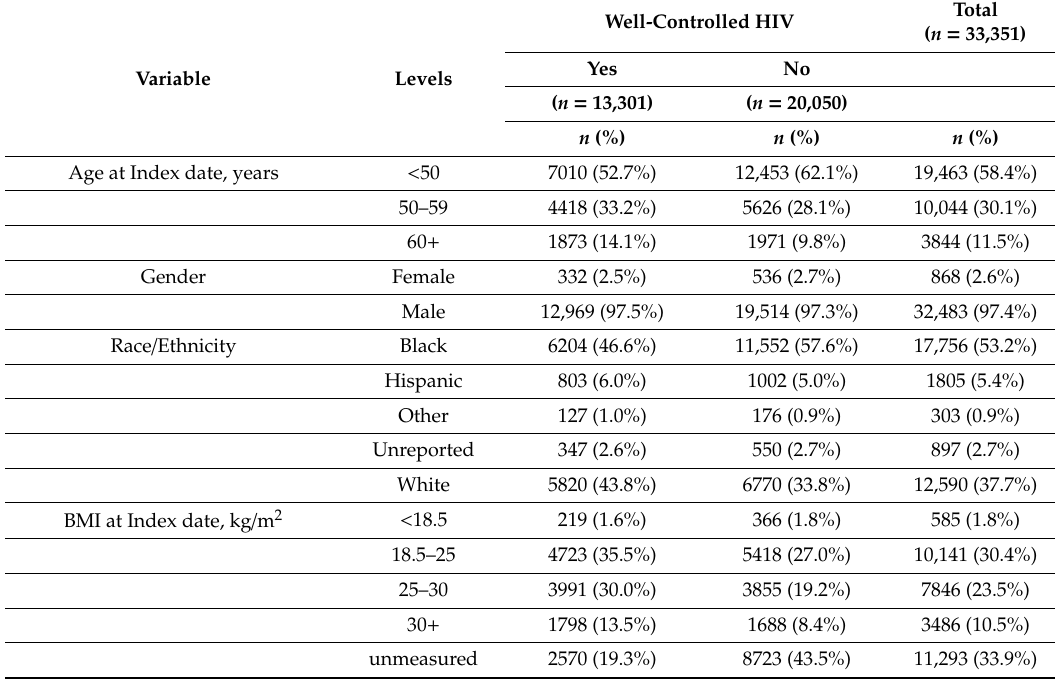
Figure 1. Cumulative incidence curve of non-small cell lung cancers by histology in people living with HIV (PWH) with a history of smoking. Table 1. Baseline and end of study characteristics of a nationwide cohort of PWH with a history of smoking ( n = 33,351) according to degree of HIV-viral